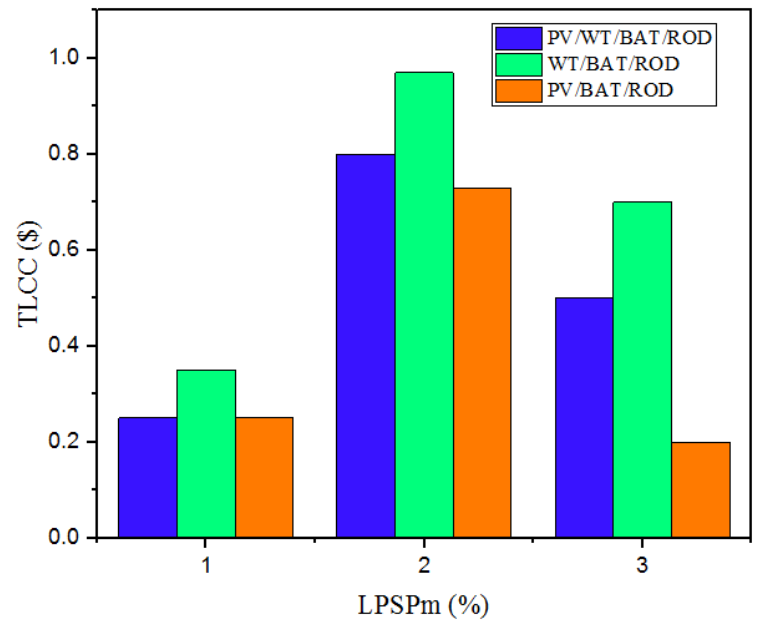
Figure 7. Hybrid energy system-based total life cycle cost (USD) for loss of power supply probability variations.